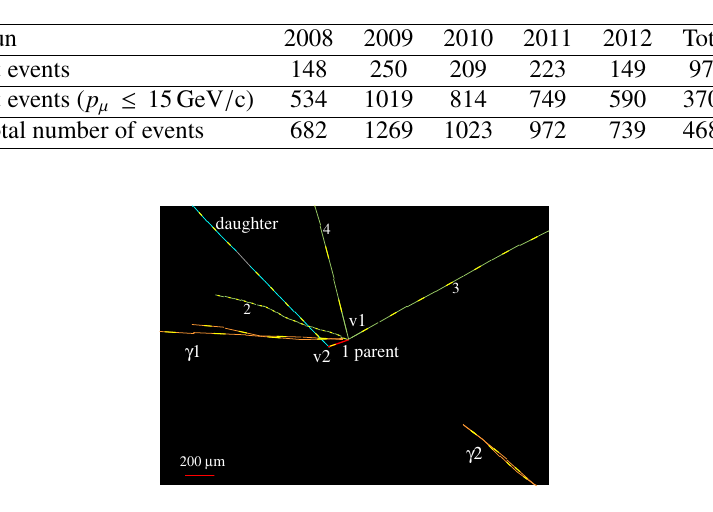
Figure 4. Display of the fourth candidate ν τ event in the view transverse to the neutrino direction.